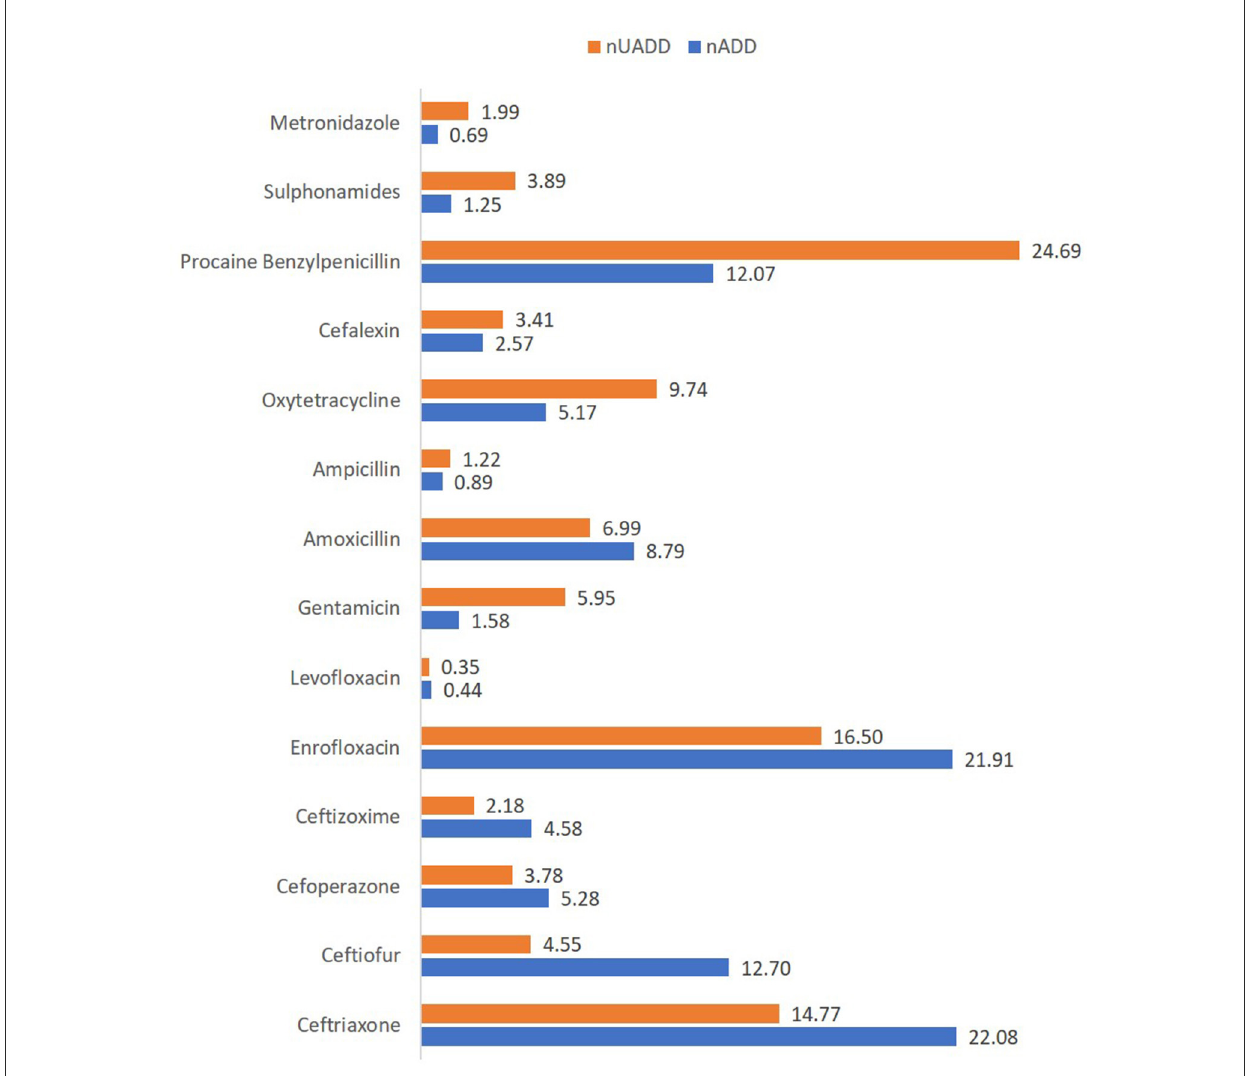
FIGURE2 Percentage of the number of used animal daily dose (nUADD) and animal daily dose (nADD) of various antimicrobials used in the herds.